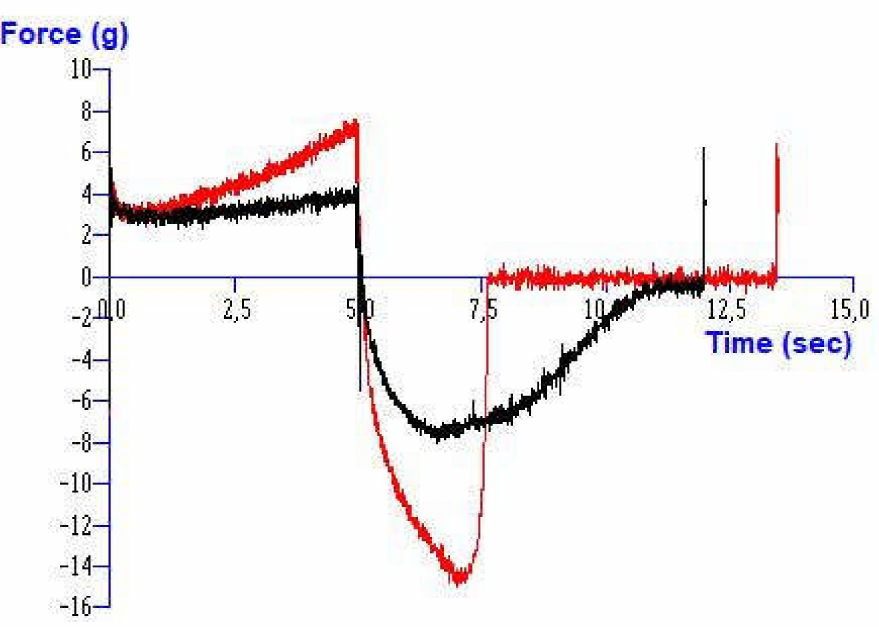
Figure 4. Texture curve (dependence of compressing force on time) of pure 6% hydrogel of NaCMC (black curve) and 6% NaCMC containing 5% of ibuprofen (red